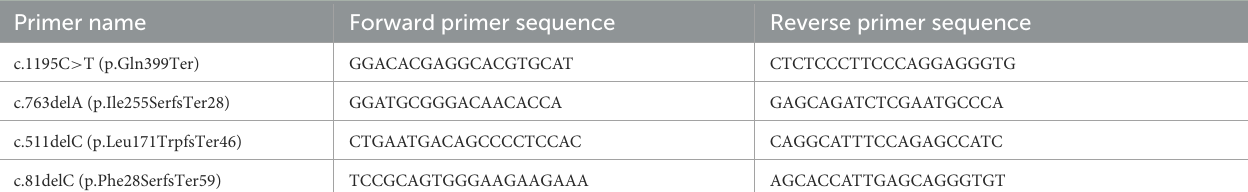
TABLE 1 The primer sequences of different mutation sites of NPRL3 gene.